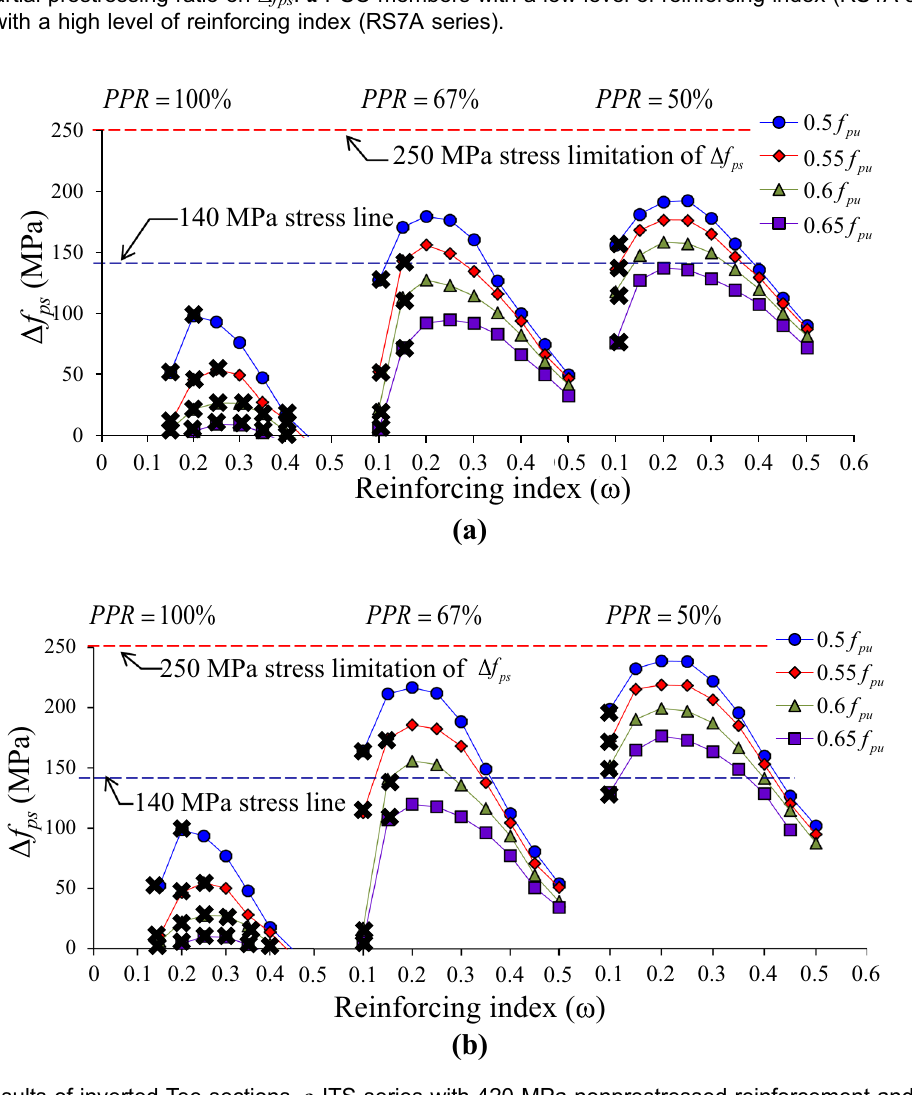
Fig. 9 Analysis results of inverted Tee sections. a ITS series with 420 MPa nonprestressed reinforcement and b ITS series with 550 MPa nonprestressed reinforcement.